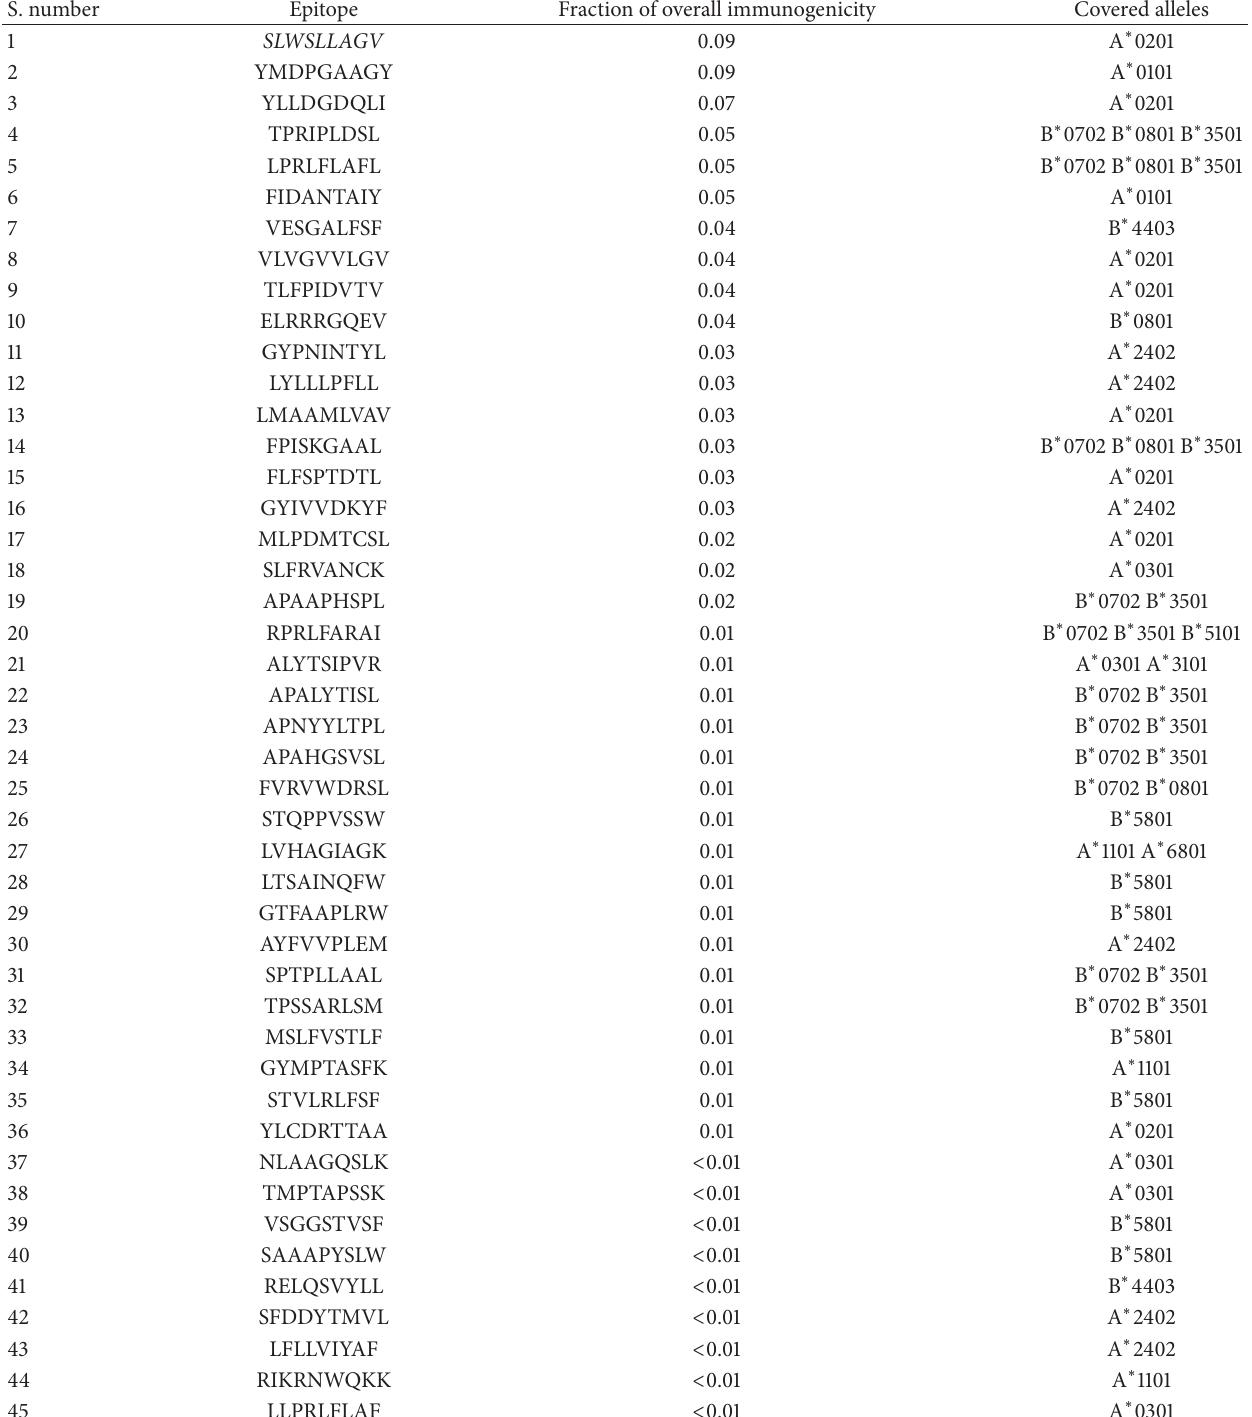
Table 5: The distribution of fractional immunogenicity for the 45 optimal epitopes against the population of North Africa. S.